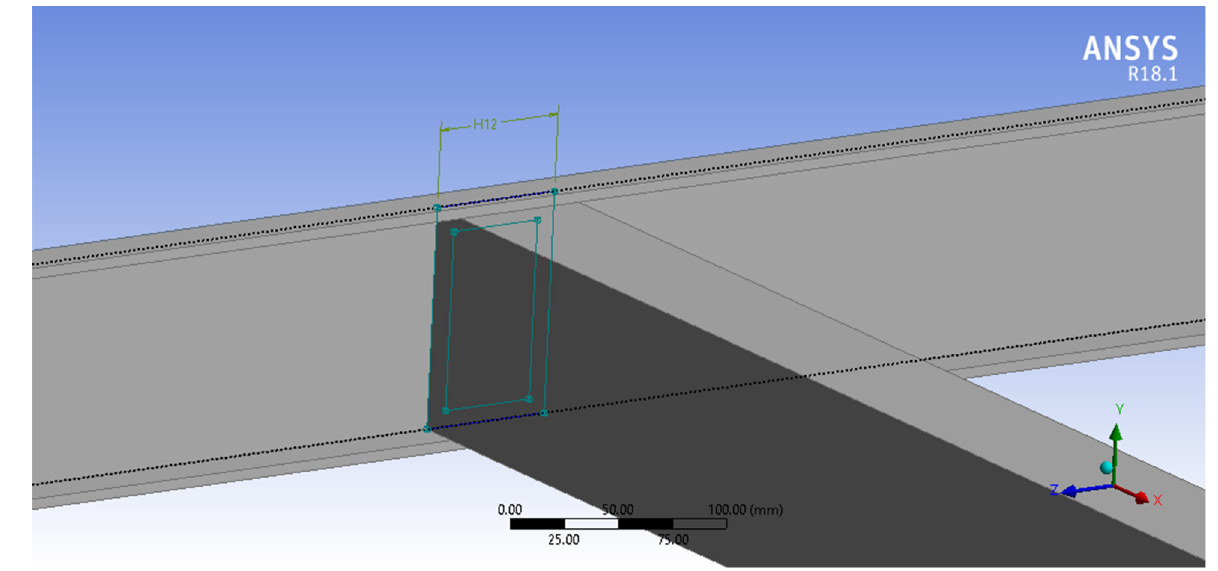
Figure 10. H12 dimension (cross member width) selected for optimization.